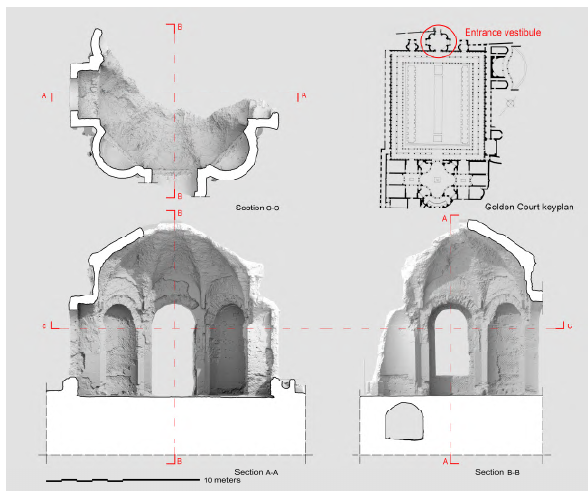
Figure 4. A comprehensive set of views of the Entrance Vestibule to the Golden Court: intrados was from TLS and extrados from